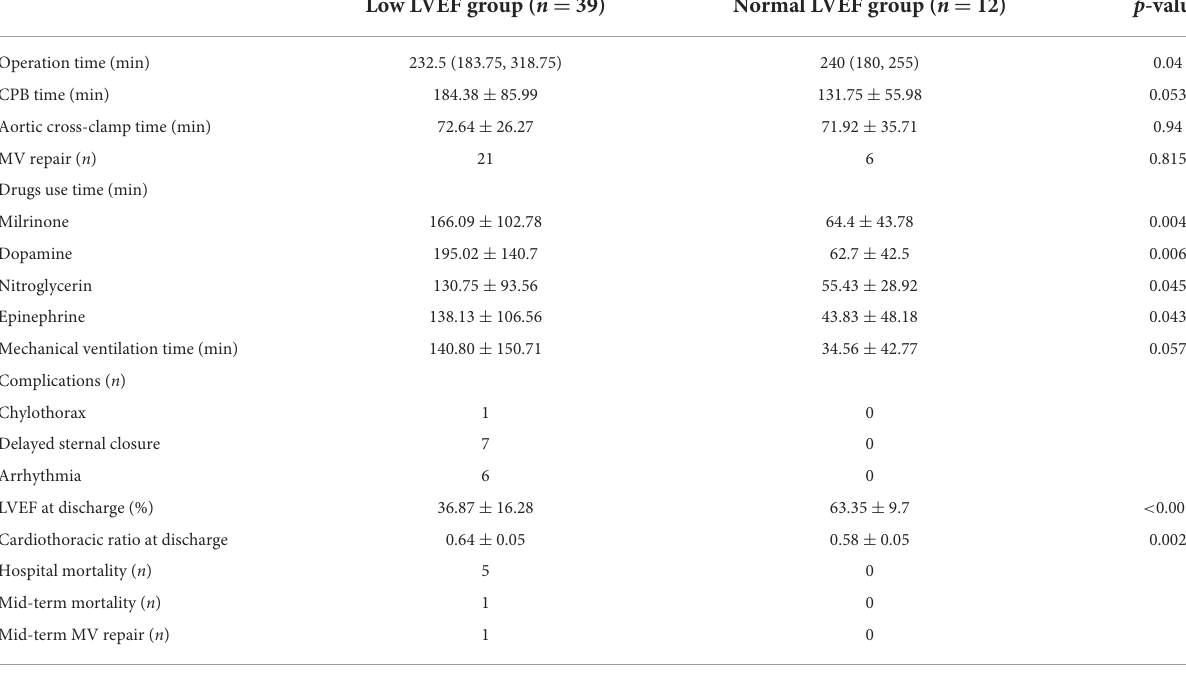
TABLE 2 Patients’ characteristics and outcomes.